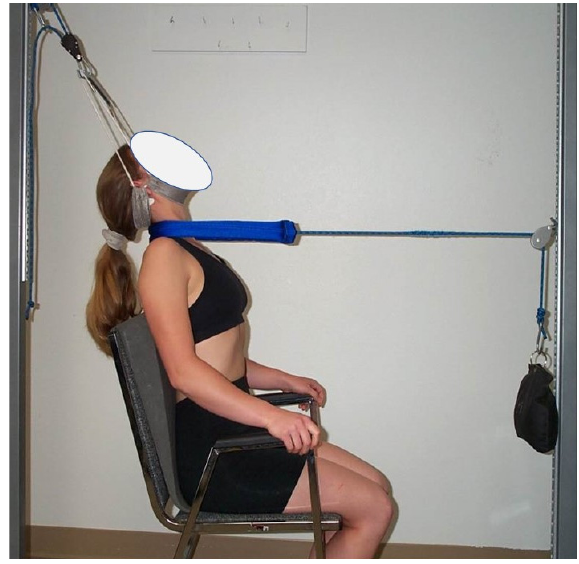
Figure 1. Three-point bending cervical traction. Photo reprinted with permission.